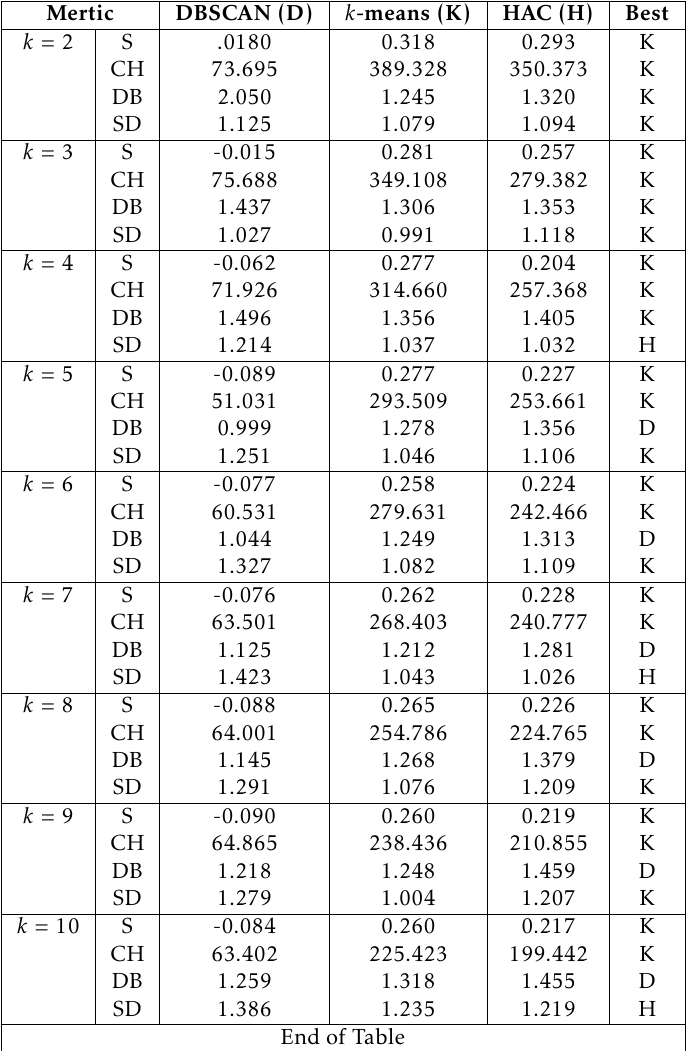
Table C.6. Performance of user clustering (Dataset PA